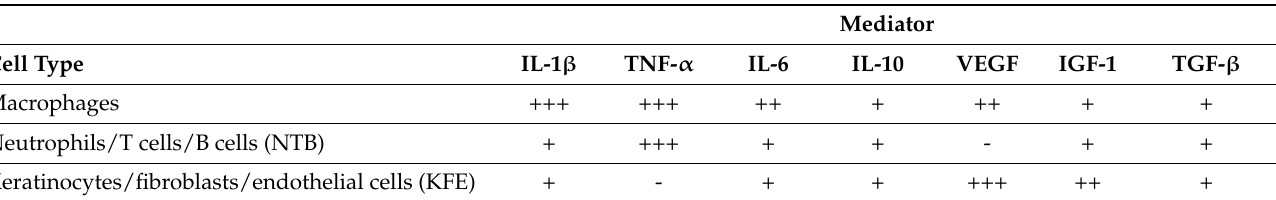
Table 1. Overlapping production of cytokines and growth factors by different wound cell types at day 5 post-injury (derived from Mirza and Koh,